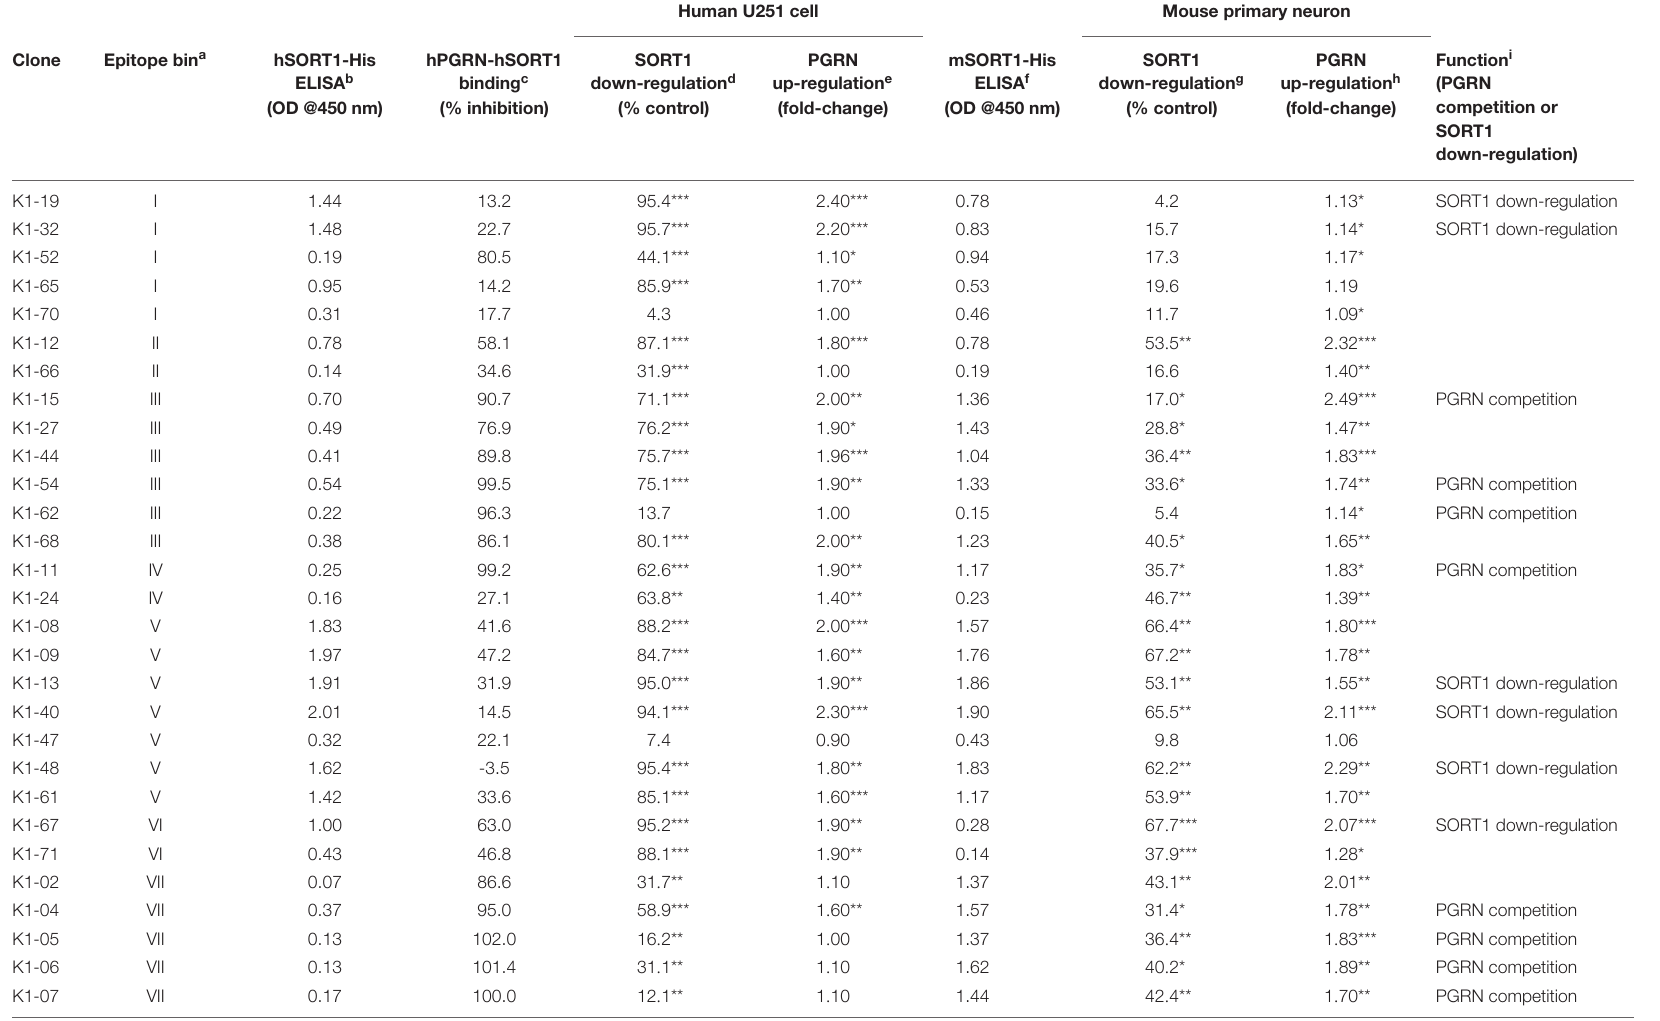
TABLE 1 | Summary of anti-SORT1 mAb